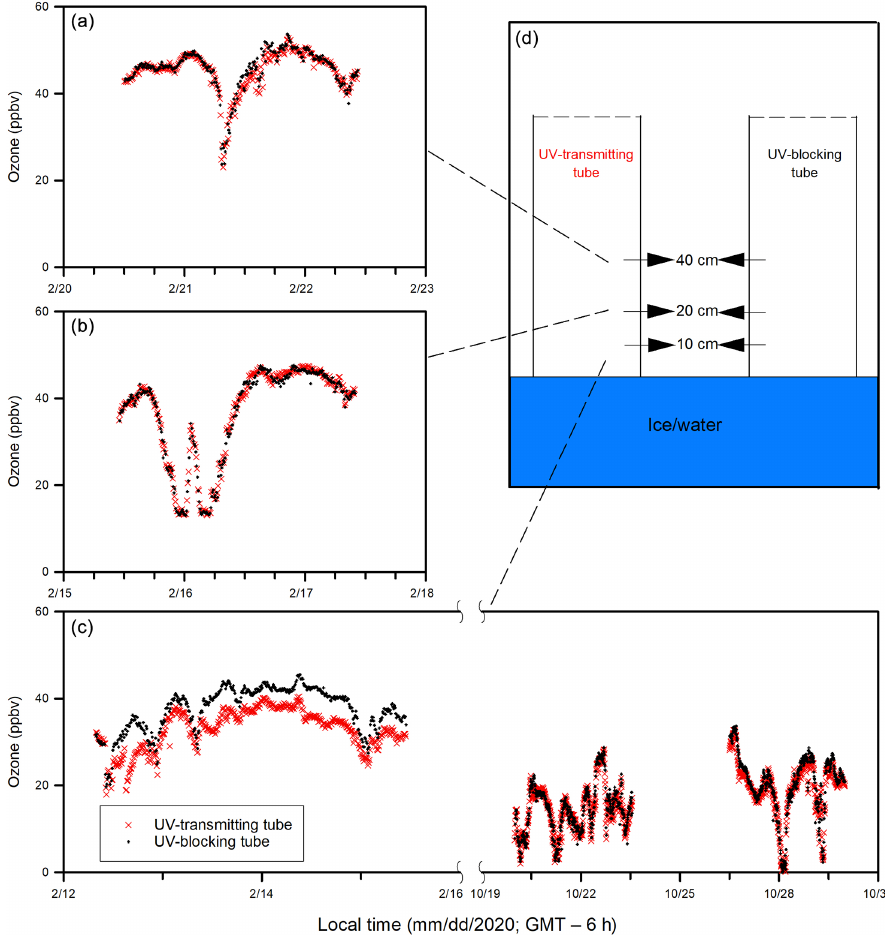
Figure 5. Ozone concentrations in the in-tube air inside the UV-transmitting and UV-blocking tubes measured at (a) 40cm, (b) 20cm, and (c) 10cm above the ice (or water) surface. The measurement schemes are illustrated in (d)